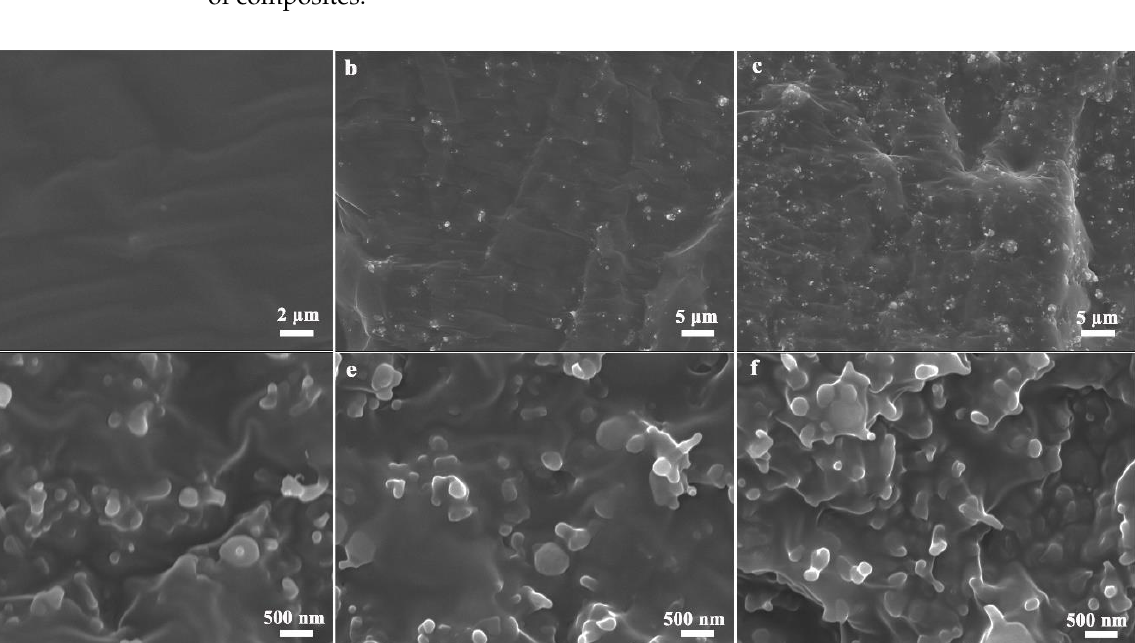
Figure 3. EDS scanning spectral results of the elements O, Al and Si: ( a ) 10 wt% B-Al 2 O 3 /SR composites and ( b ) 70 wt% B- Al 2 O 3 /SR composites.